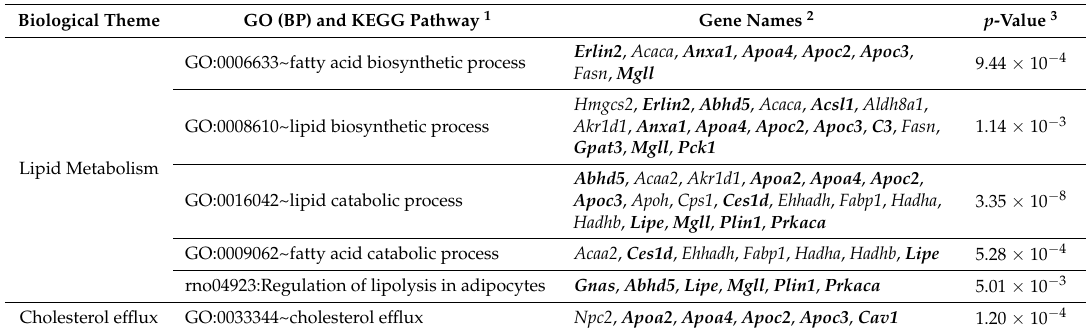
Table 5. Enriched gene ontology biological process terms and KEGG pathways in the list of differentially expressed proteins with Purple Carrots in adipose tissue that are involved in lipid metabolism and cholesterol